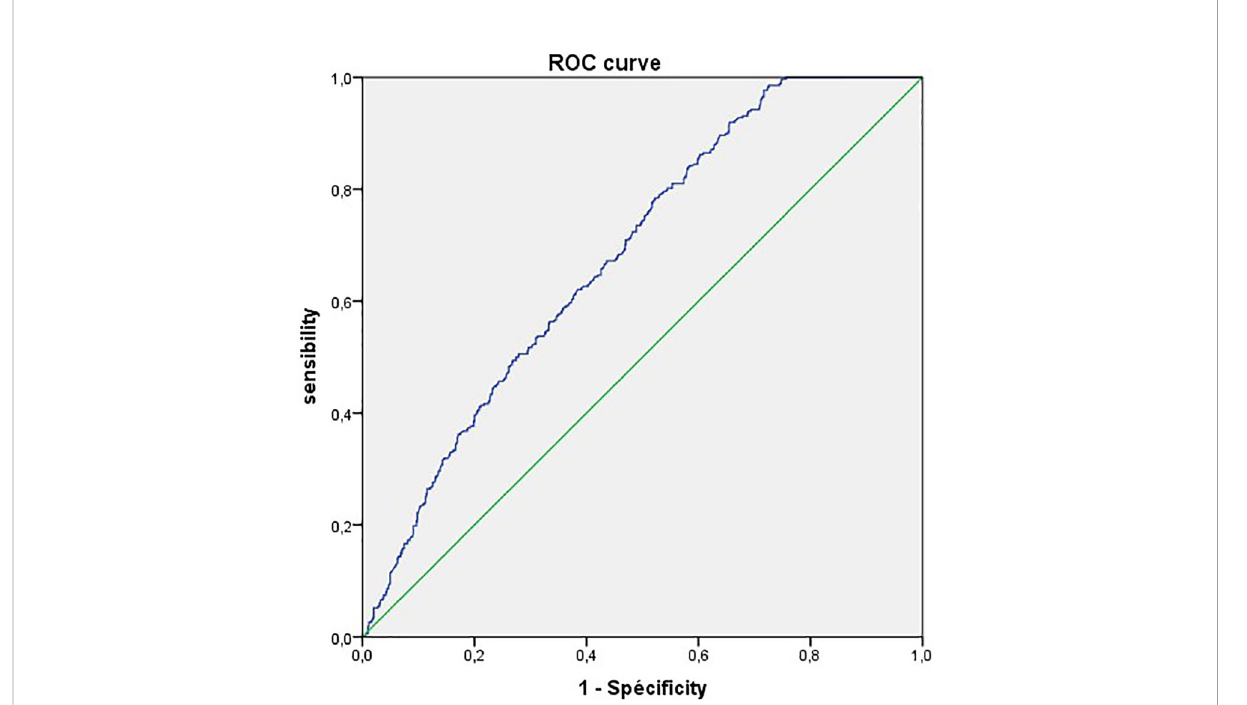
FIGURE 1 Receiver operating characteristic (ROC) curves of CRP for predicting the disease severity in